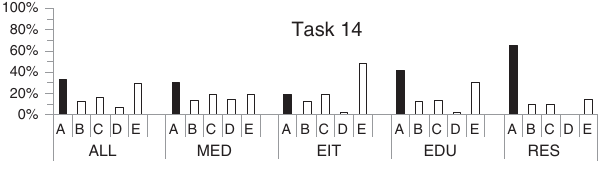
FIG. 3. The students ’ responses to the task referring to the gas pressure concept. For a detailed description see Fig. 1.